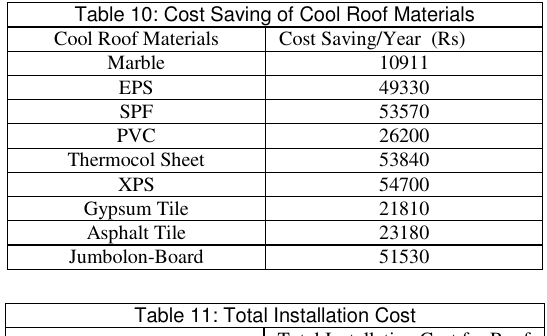
Table 11: Total Installation Cost